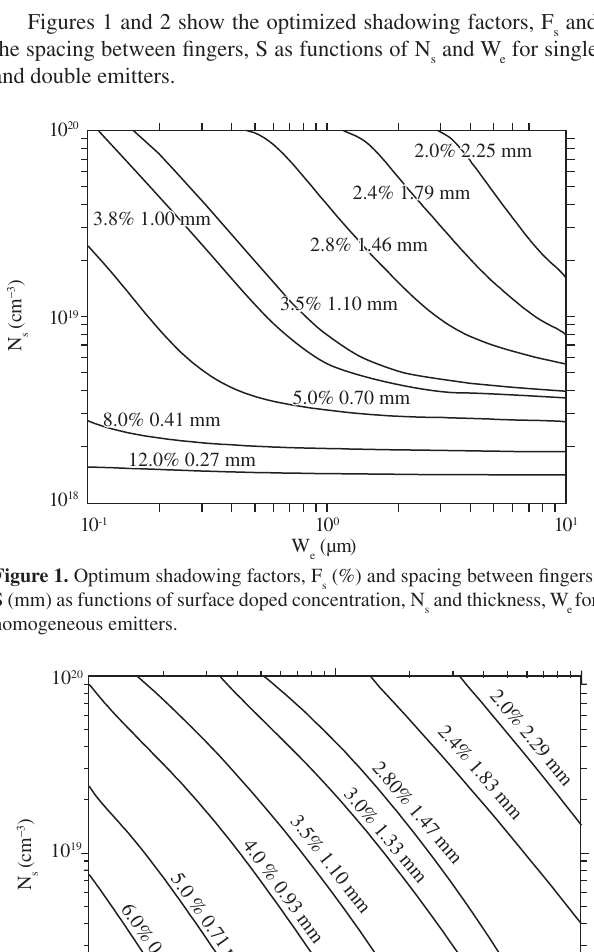
Figure 2. Optimum shadowing factors, F S (mm) as functions of surface doped concentration, N for DD emitters.